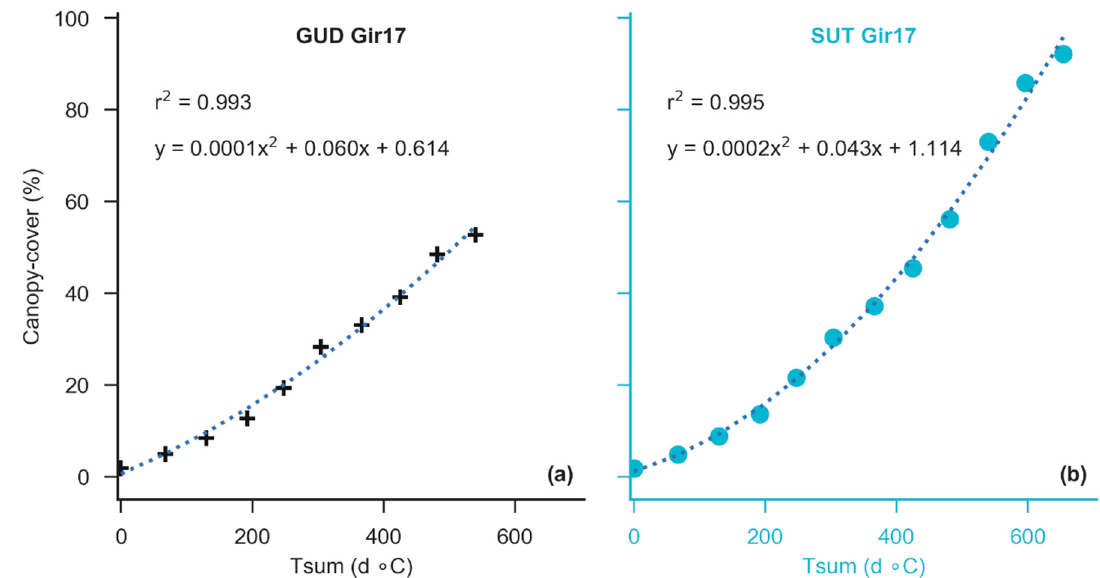
Figure 2. Measured canopy cover (%) as a function of Tsum (d °C) for improved cultivar Gudene (GUD) ( a ) and the local cultivar Suthalo ( b ) during belg -2017 in Gircha. The canopy cover—Tsum curve shows a quadratic relation. The lines in each plot show the quadratic function curve (canopy cover = slope1 × Tsum 2 + slope2 × Tsum + intercept) and the quadratic correlation coefficient ( r 2 ) are shown.